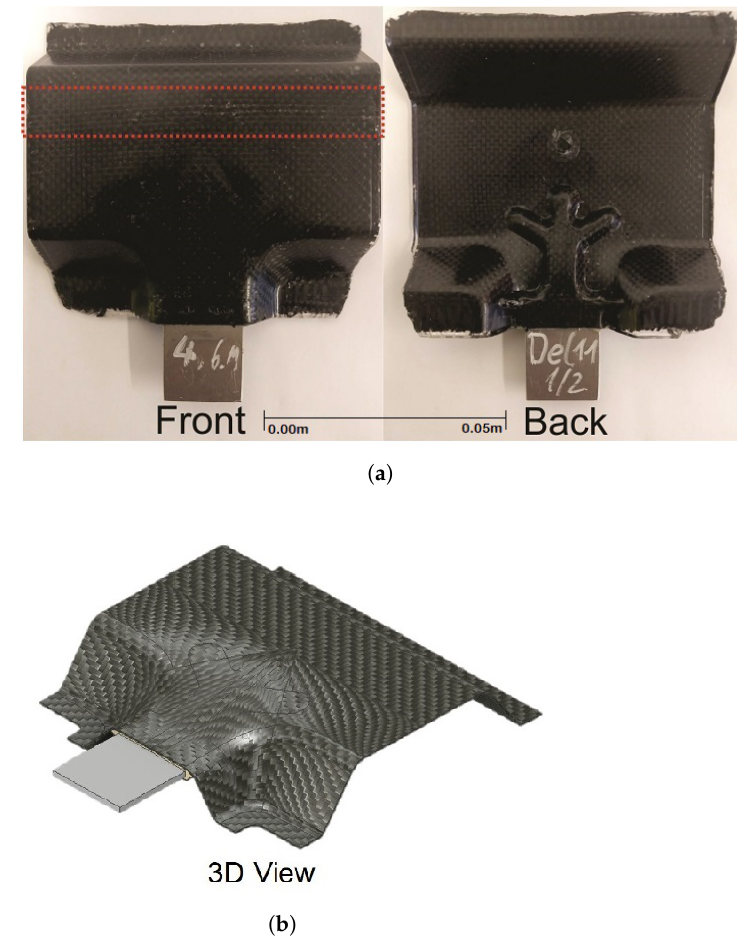
Figure 1. Inspected sample. ( a ) Front, back, and ( b ) 3D view. The red box indicates the position of the artificial delamination.